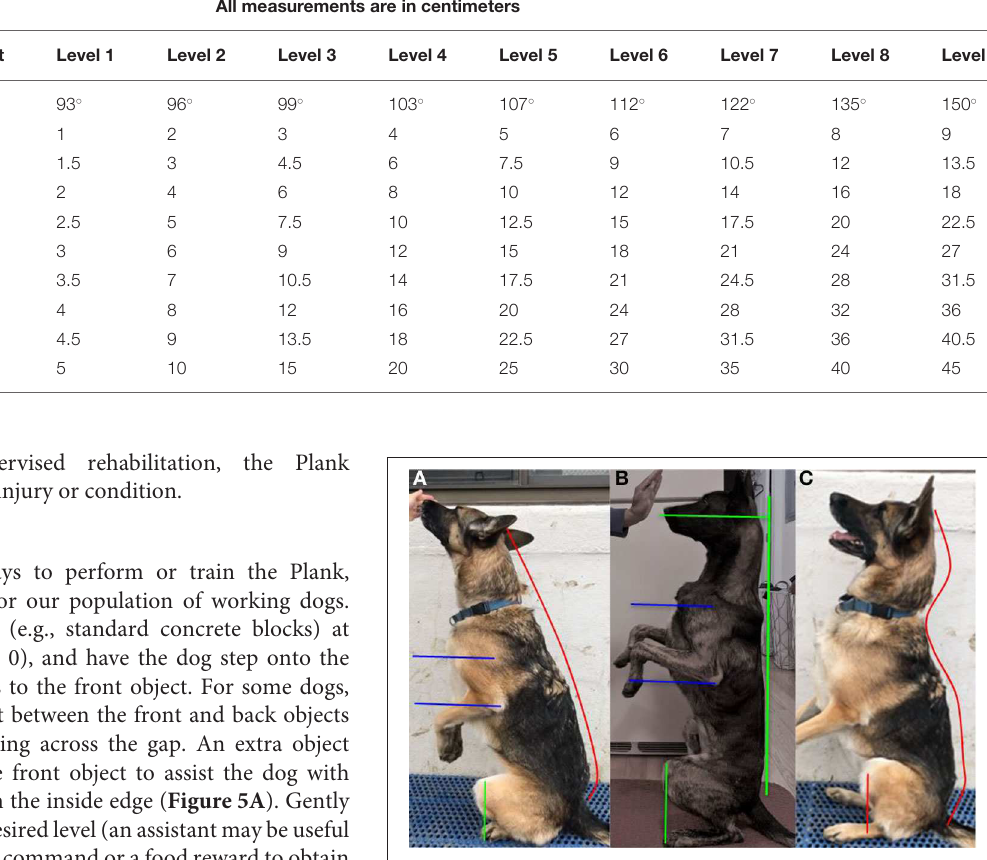
TABLE 3 | Plank hip height measurements, corresponding Plank level increment, total distance for each hip height and Plank level, and approximate hip angle achieved. Plank hip height, increment, and level All measurements are in centimeters